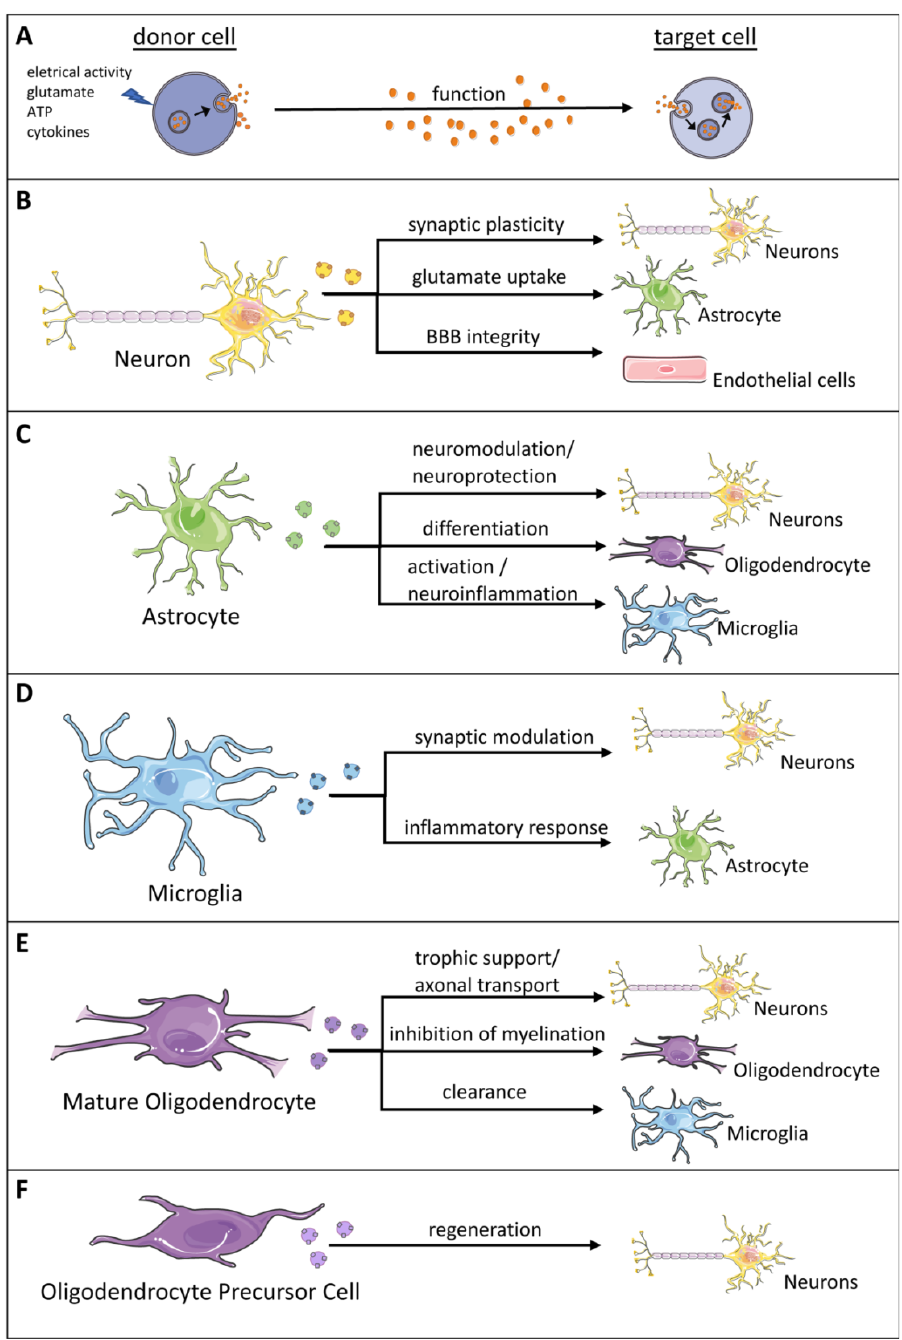
Figure 4. Exosome-mediated intercellular communication among brain cells. Exosomes from a parent cell may have several target (or recipient) cells within brain to ensure maintenance of homeostasis. ( A ) Exosome release in the CNS occurs in response to neurotransmitter signaling and therefore is controlled by electrical activity. For example, exposure to potassium chloride depolarizes neurons, often known as electrically active neurons. Depolarized neurons release glutamate that binds to and stimulates AMPA and NMDA receptors on oligodendrocytes. Activation of glutamate receptors increases intracellular calcium levels in oligodendrocytes. An increase in intracellular calcium induces release of exosomes by oligodendrocytes [109]. ATP-mediated stimulation of P2 purinoceptor subtype, P2X7 stimulates exosome release by microglia [110] and astrocytes [111]. Serotonin also stimulates exosomes release by microglia [112]. ( B ) Neurons regulate certain functions of neurons, astrocytes, and endothelial cells through release of exosomes [113]. In particular, neuronal exosomes eliminate synapses and stimulate phagocytosis by microglial cells [114]. Neuronal exosomes re- leased in response to synaptic activation, control expression of glutamate transporters in astrocyte